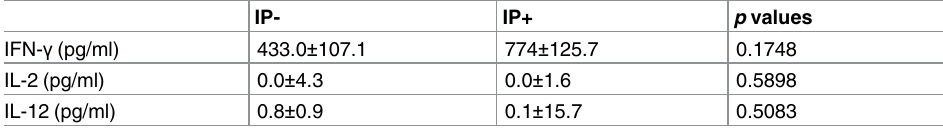
Table 5. Comparison of Th1 cytokine